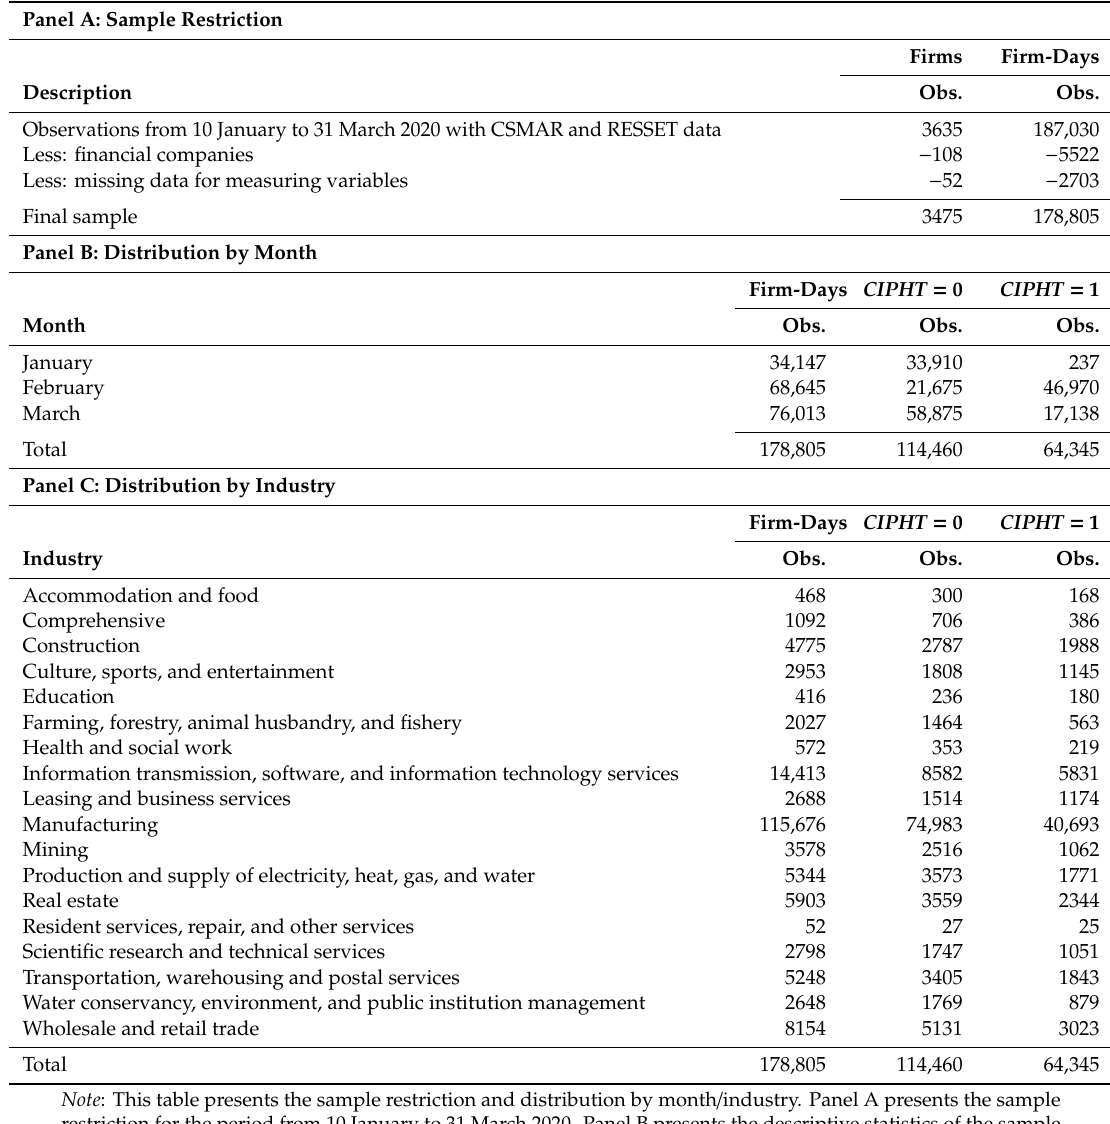
Table 1. Sample restriction and